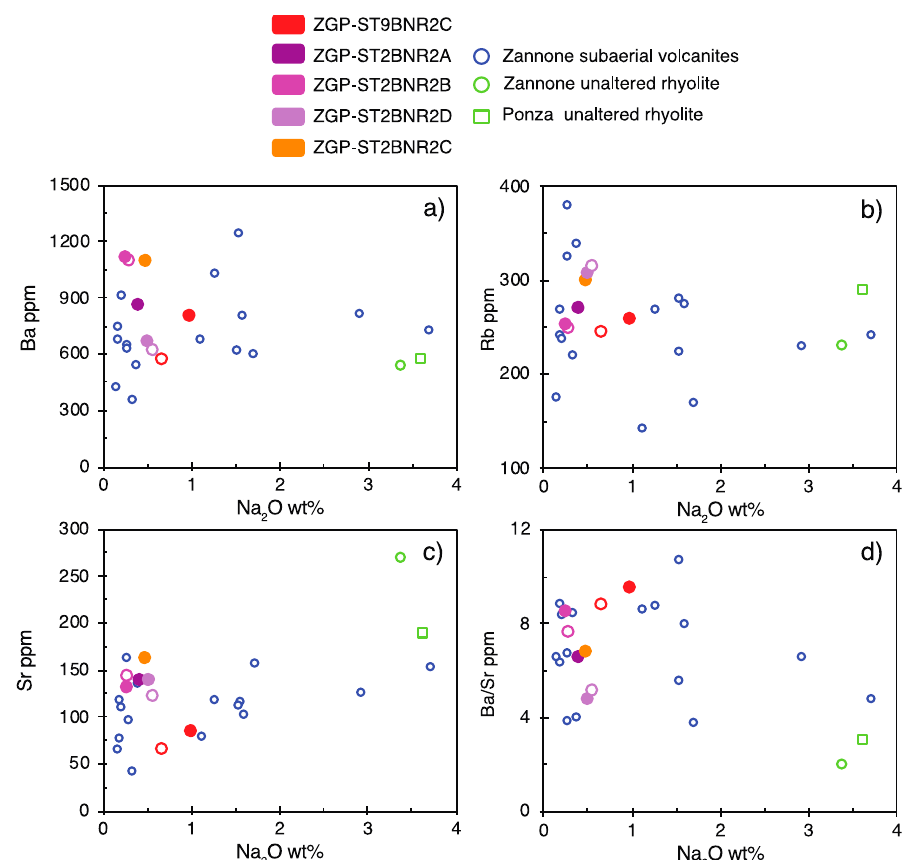
Figure 15. Correlation plots of ( a ) Ba, ( b ) Rb and ( c ) Sr trace elements versus Na 2 O concentration; ( d ) shows the variation of Ba / Sr ratio as function of Na 2 O depletion of altered ZGP rhyolite clasts. Zannone subaerial volcanites, unaltered Zannone and Ponza volcanics are as in Figure 14. Symbols of ZGP clasts: full—inner portion, empty—outer portion.